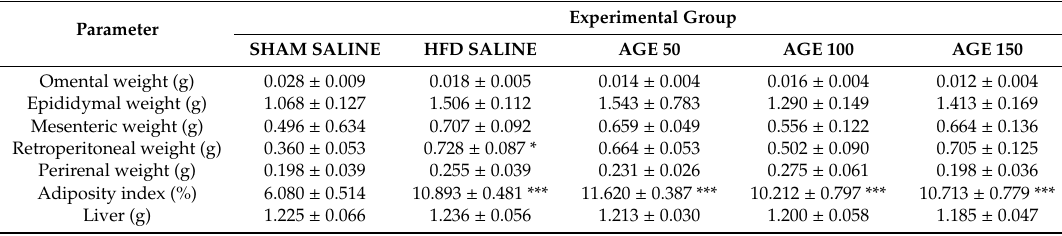
Table 4. E ff ects of AGE on fat pads, adiposity index, and liver weight.